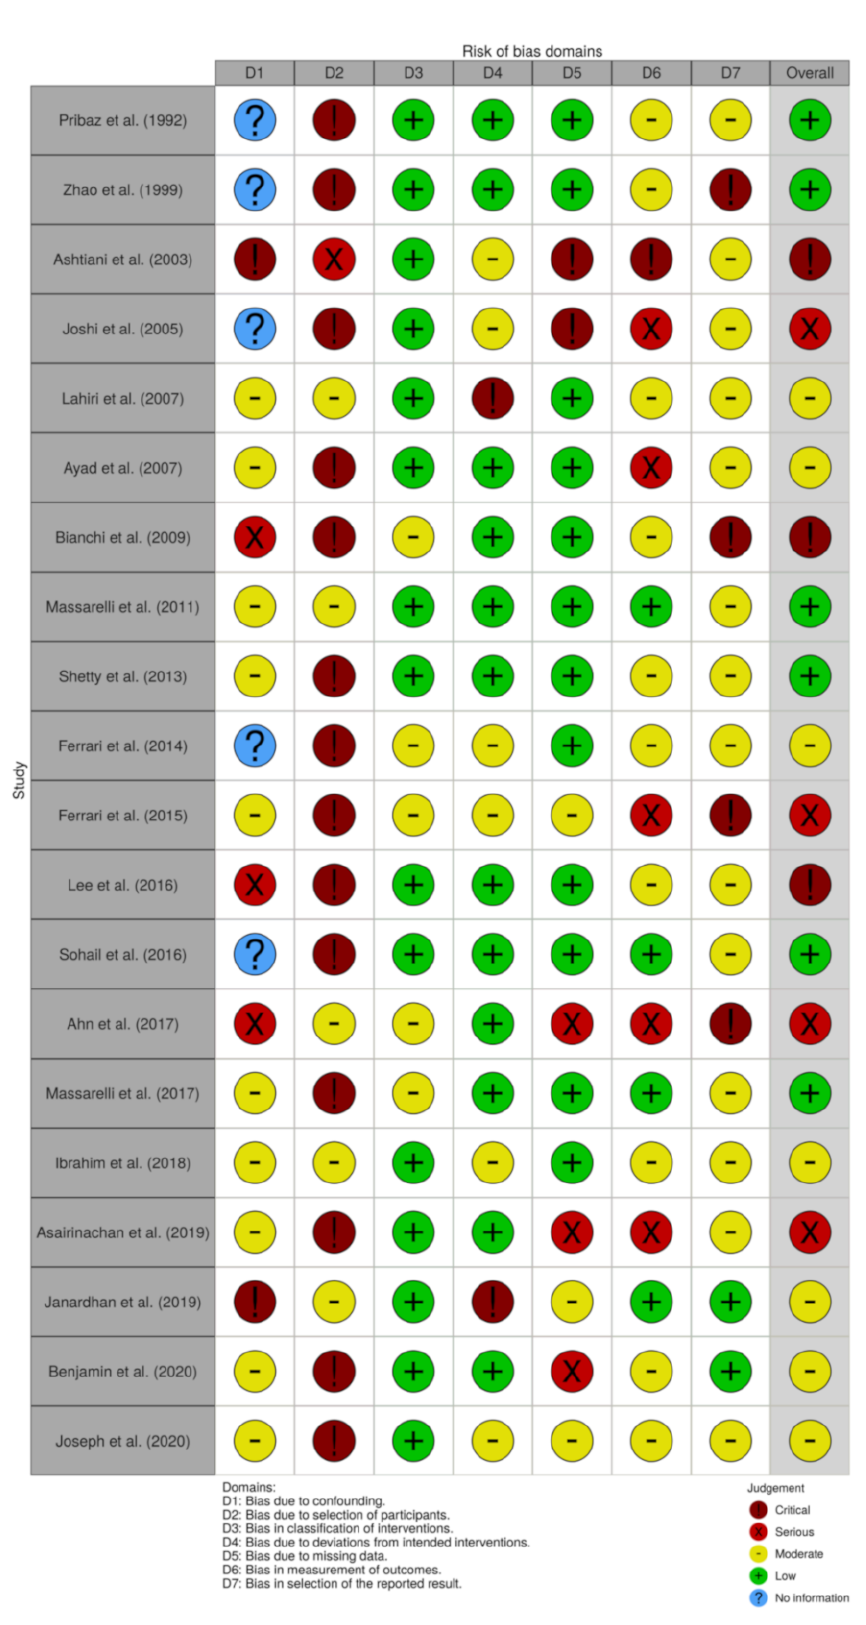
Figure 2. ROBINS-I Traffic Light Plot bias